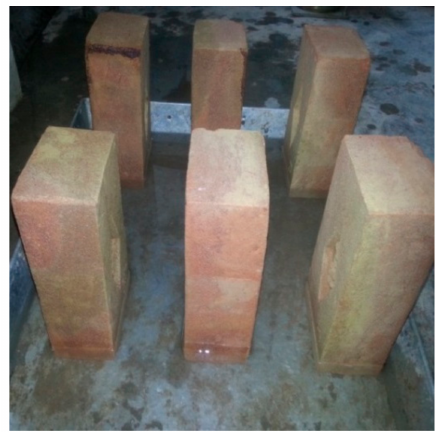
Figure 5. Efflorescence